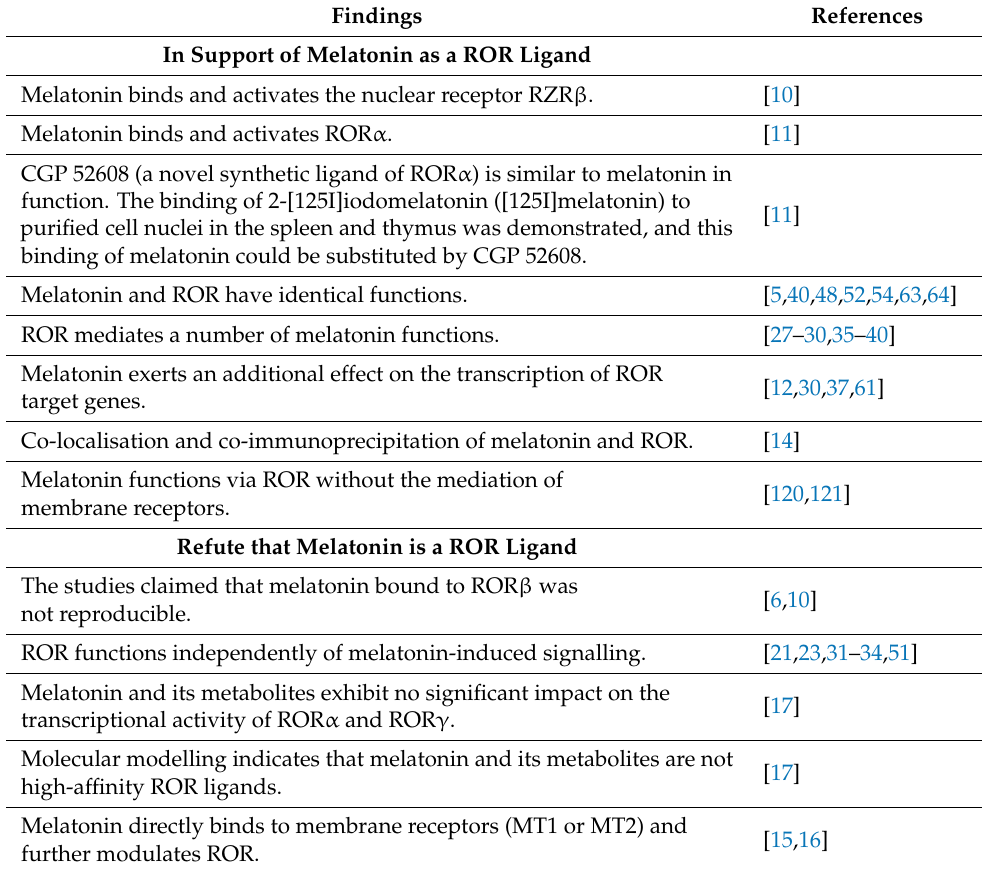
Table 2. Findings for or against the hypothesis of melatonin as a ROR